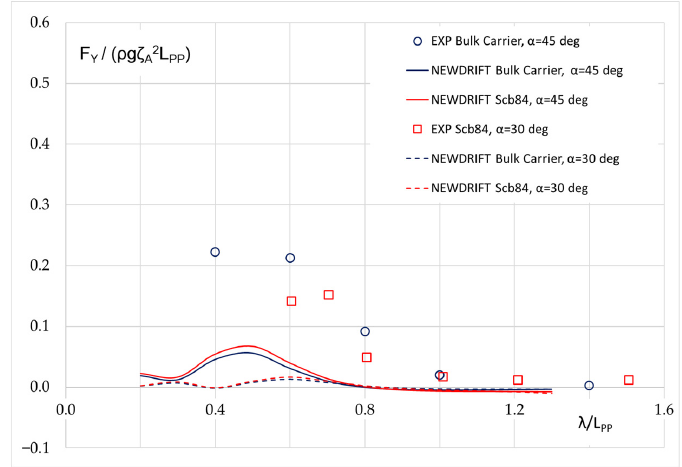
Figure 9. Mean sway force in regular stern oblique waves, Fr = 0.10.